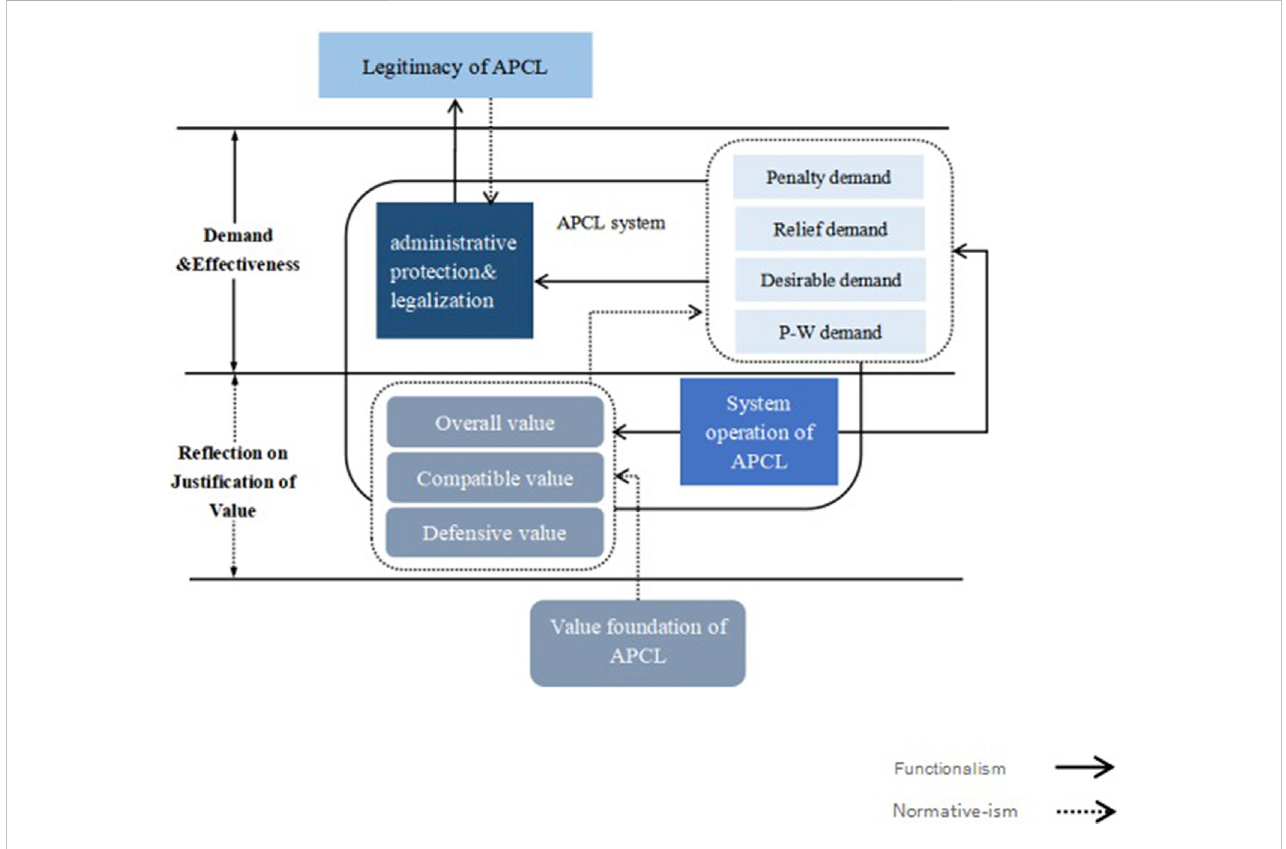
FIGURE 1 Path map for reviewing the legitimacy of APCL